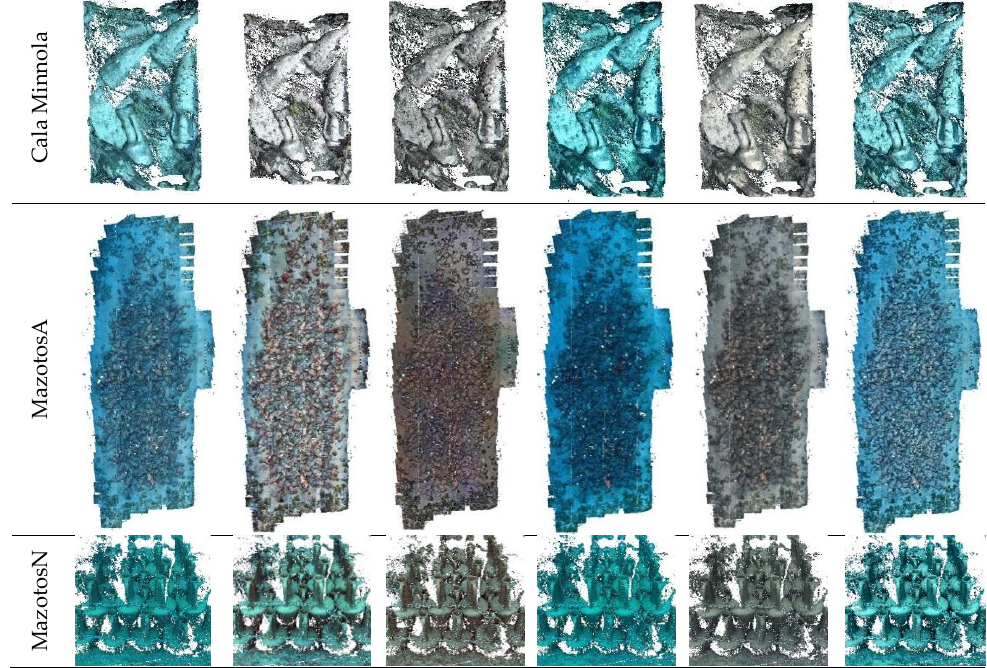
Figure 6. The dense point clouds for all the datasets and for all the available imagery.